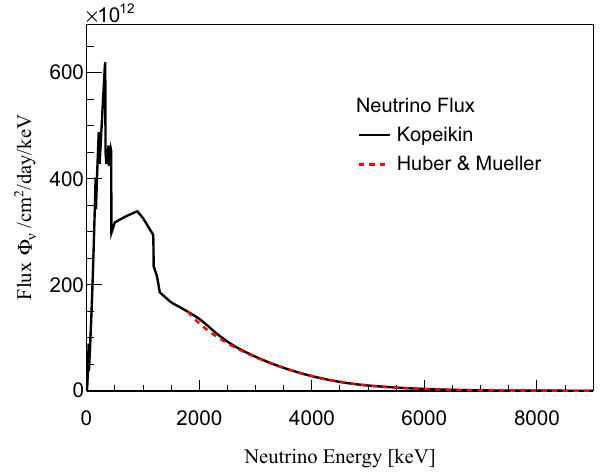
Fig. 23 Expected neutrino fluxes for the NEON experiment are pre- sented for the Kopeikin [62] and Huber [82] and Mueller [83] models. In the Kopeikin model, the fission fractions of 0.56, 0.31, 0.07, and 0.06 for 235 U, 239 Pu, 238 U, and 241 Pu, respectively, are used. As the Huber and Mueller model provided the neutrino flux from each isotope, we used the fission fractions of 0.577, 0.296, 0.072, and 0.055 for 235 U, 239 Pu, 238 U, and 241 Pu,